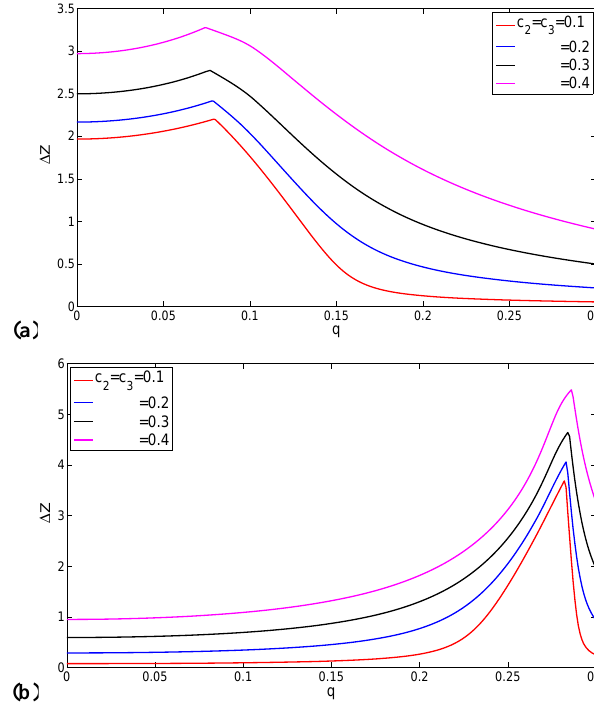
Fig. 4. Modulation intensity for the carrier wave steepness ε =0.2 as a function of the initial phase angle θ for: (a) p = 0 . 2; (b) p =0.45. for c 1 = c 2 = 0 . 4, the modulation amplitude in the vicinity of θ = 0 is higher for p = 0 . 45 in Fig. 4b as compared to that for p = 0 . 2 in Fig. 4a.